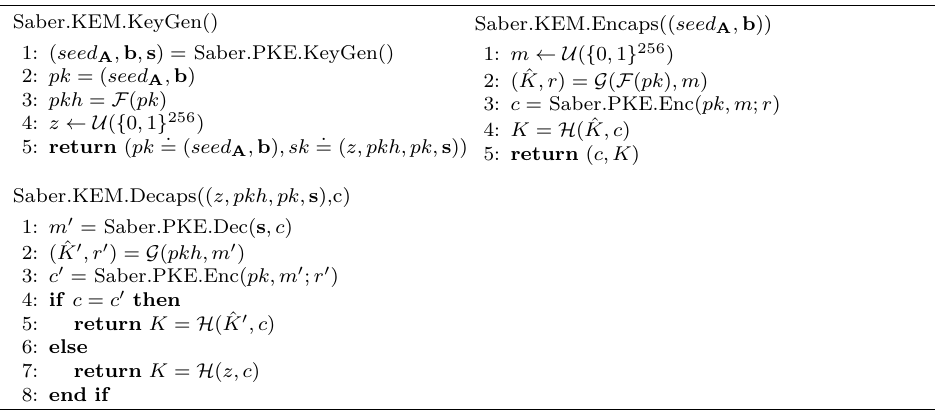
Figure 2: Description of Saber.KEM from [D +